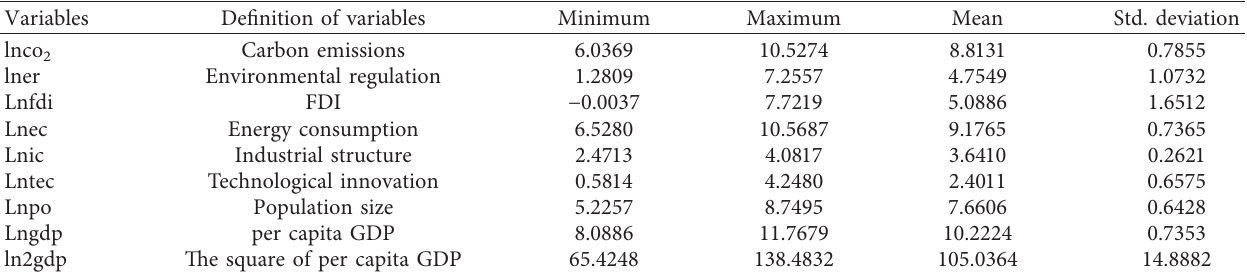
Table 1: Definition of variables and descriptive statistical results.